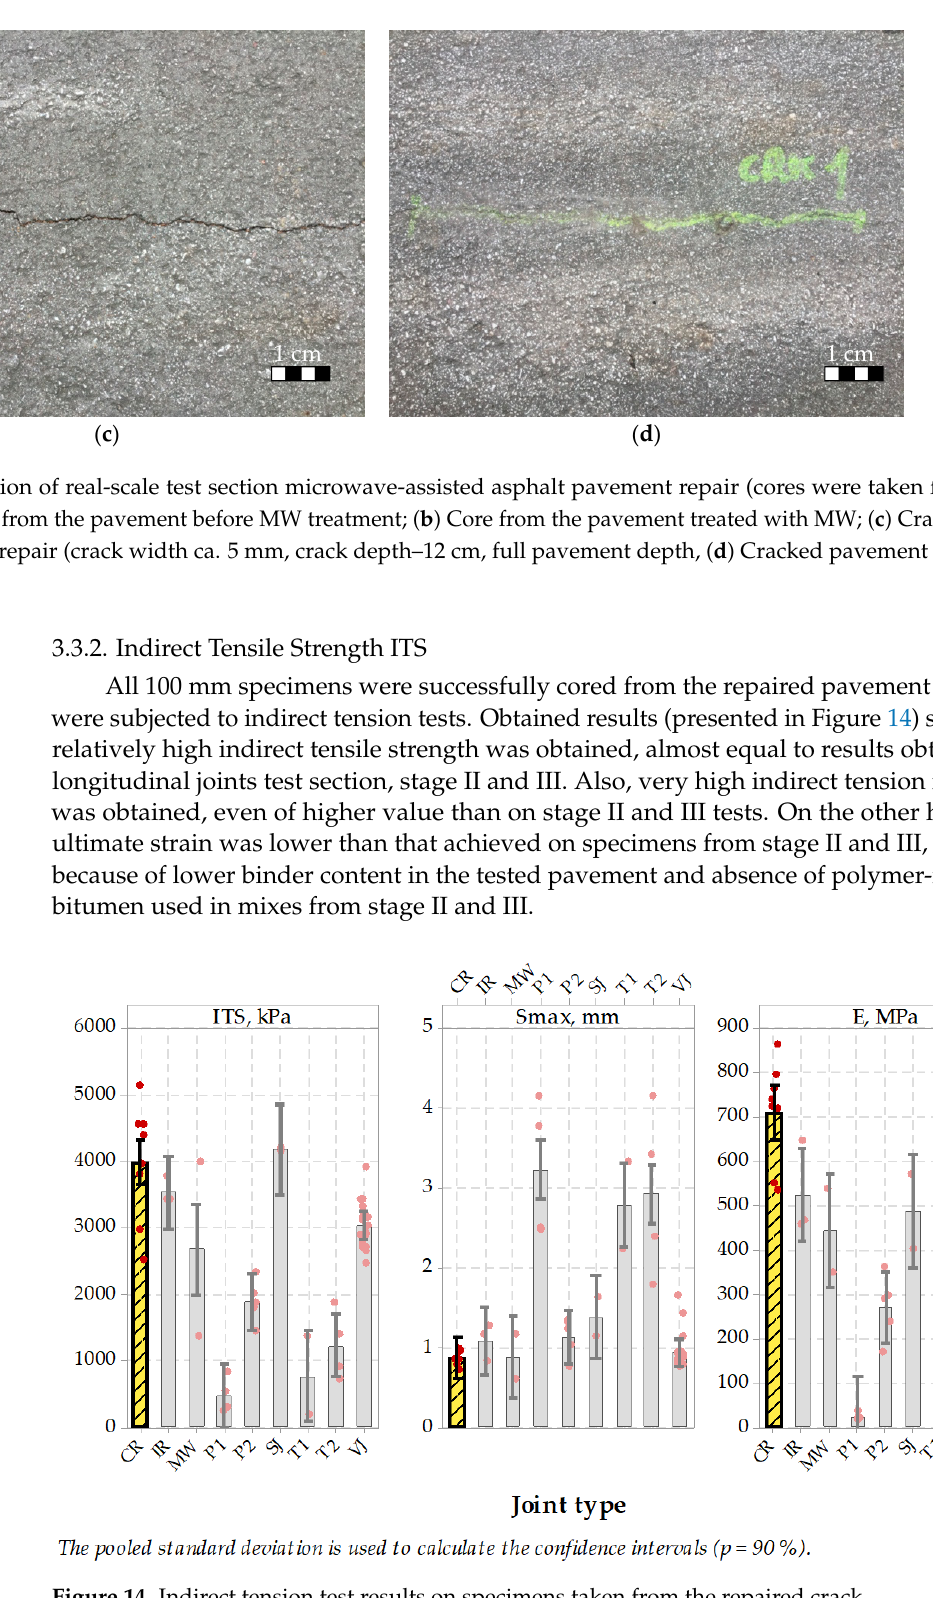
Figure 14. Indirect tension test results on specimens taken from the repaired